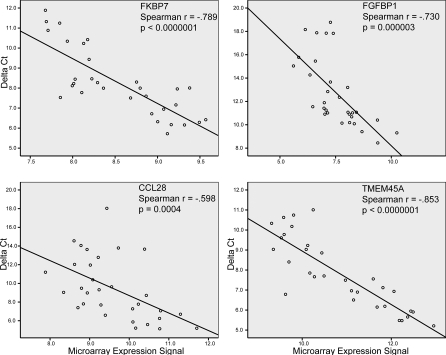
Scatter Plots Showing the Microarray Expression Signal Versus the ΔCt Obtained by qRT-PCR for Four Individual GenesGenes are FGFBP1, FKBP7, TMEM45A, and CCL28 from our overall survival profile. ΔCt of the gene is obtained by subtracting the mean Ct value of GAPDH from the mean Ct value of the gene. Both axes are on log2 scale.